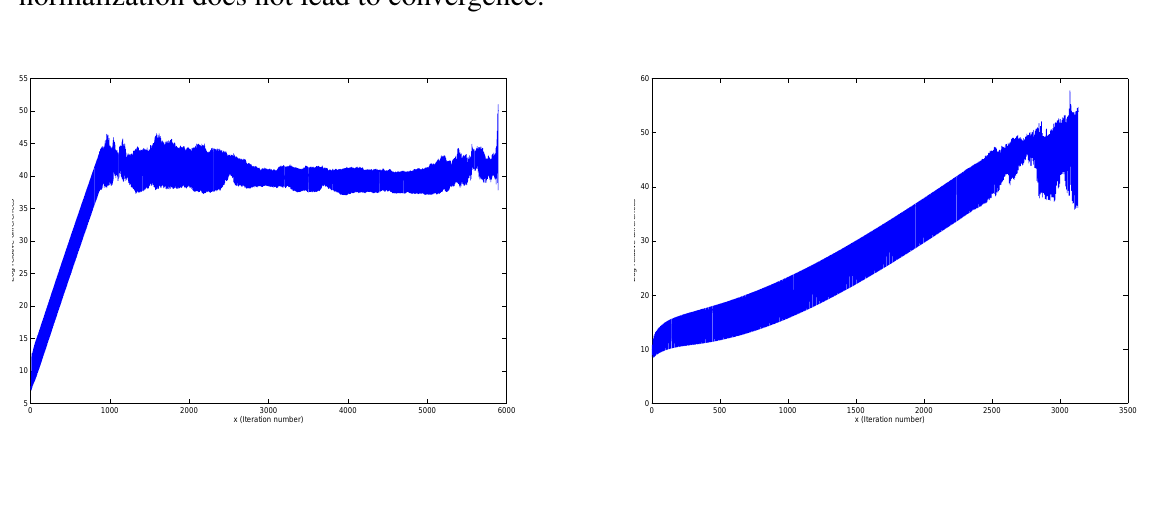
Figure 3. Two examples of simultaneous normalization: these illustrate that simultaneous normalization does not lead to convergence.